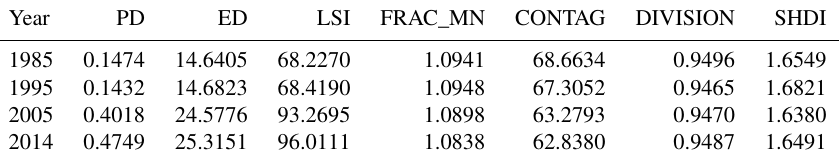
Table 3. Landscape indexes of land use from 1985 to 2014.